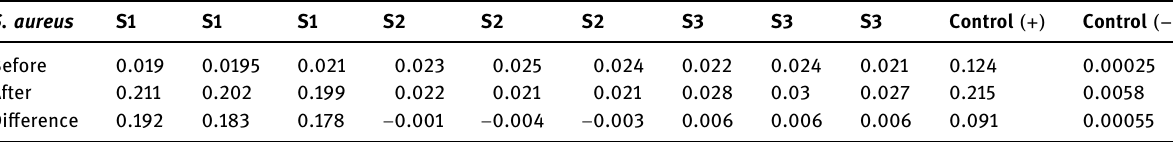
Table 6: Antibacterial activity of fi lms against S. aureus before and after incubation S. aureus